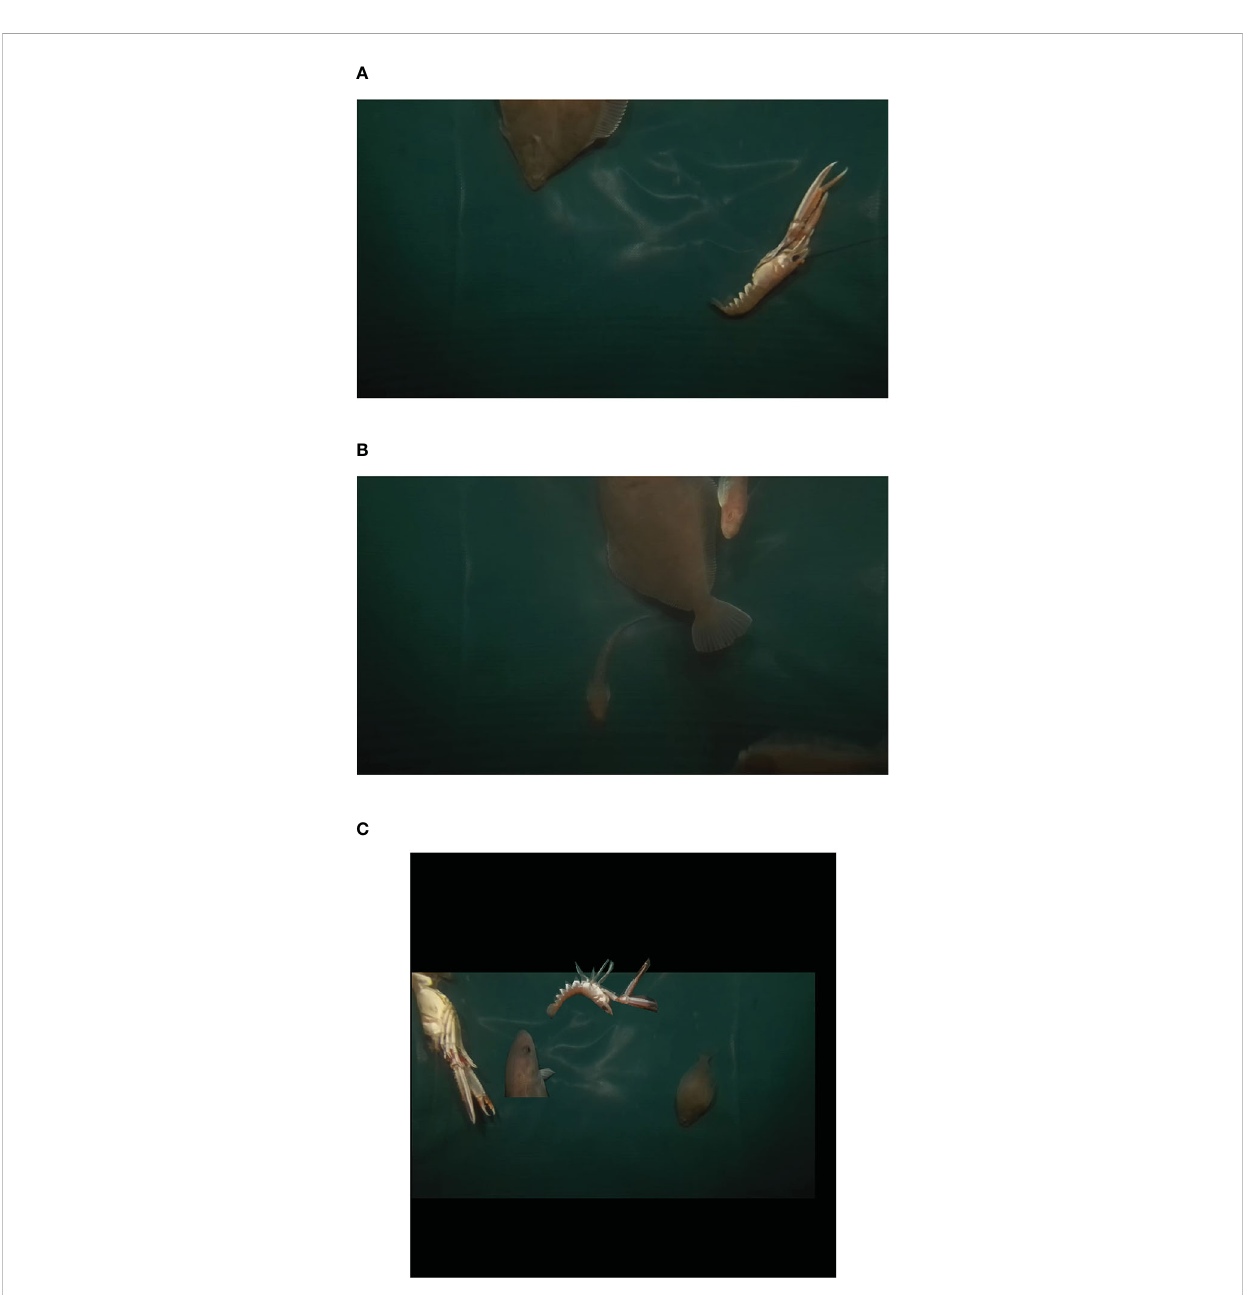
FIGURE 3 Samples from the image dataset. (A) An image with a Nephrops instance. (B) An image with some other instances. (C) An image with copy-paste